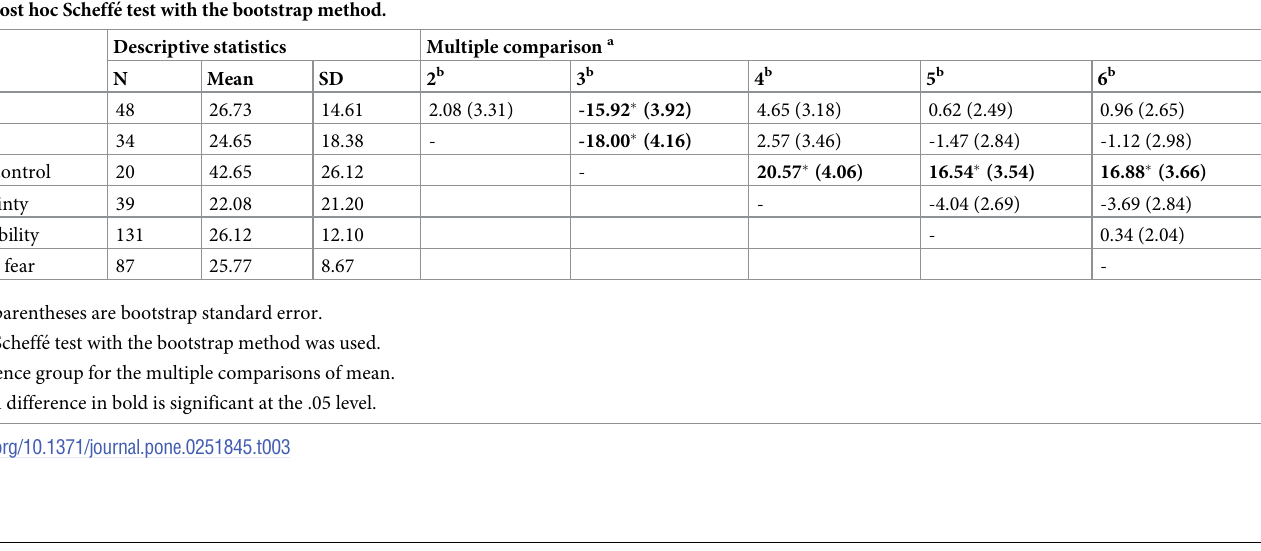
According to the ANOVA results (Table 2), the types of fear-embedded message, had a signifi- cant effect on the Google search volume for face masks [ F (3,358) = 5.67, p < .05]. It means that the Google search volume for face masks varied by the dissemination of various types of fear-embedded message. Specifically, the results from post hoc comparisons using the Scheffe´ test with the bootstrap method (Table 3) indicated that only the mean score for the loss of con- trol group ( M = 42.65, SD = 26.12) was significantly different from the other groups ( M = 26.73, SD = 14.61, for mistrust ; M = 24.65, SD = 18.38, for severity ; M = 22.08, SD = 21.20, for uncertainty ; M = 26.12, SD = 12.10, for susceptibility ; M = 25.77, SD = 8.67, for without fear ).